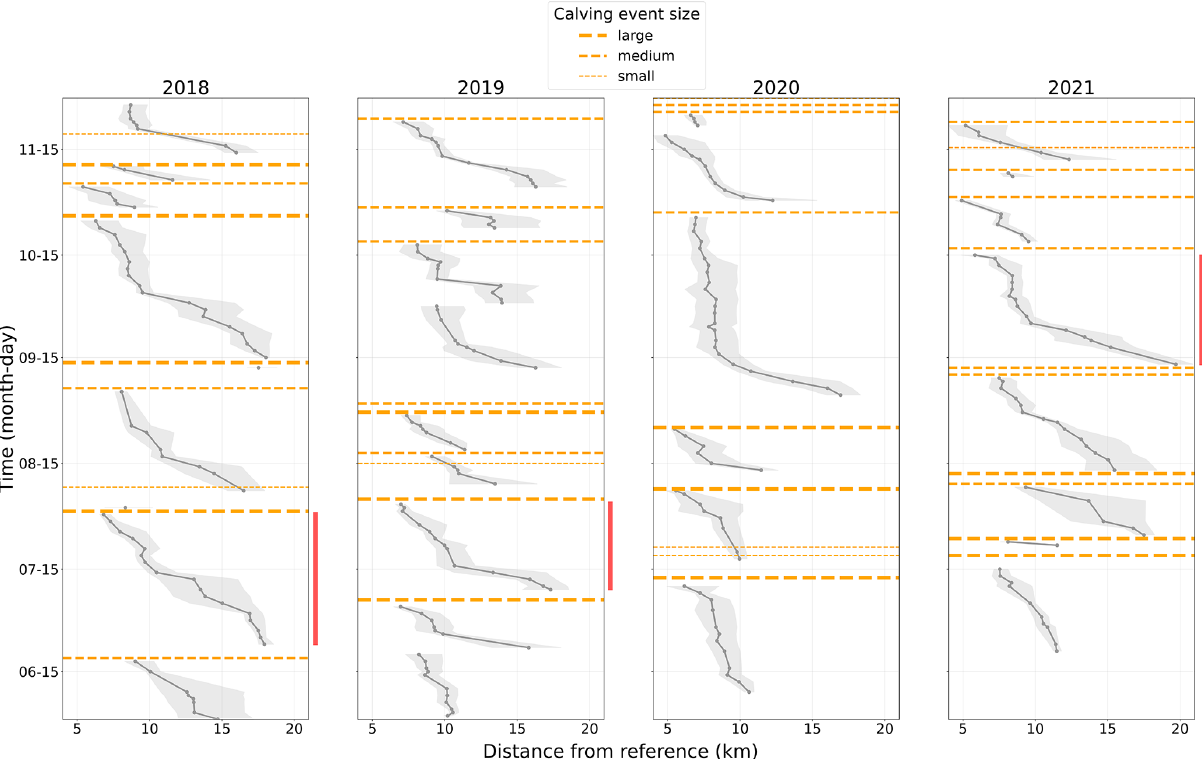
Figure 5. Detection and tracking of IMW episodes at KG during the June–November period from 2018 to 2021 presented in a similar manner as in Figs. 2 to 4. The three vertical red bars indicate the three IMW episodes presented in Fig. 2.